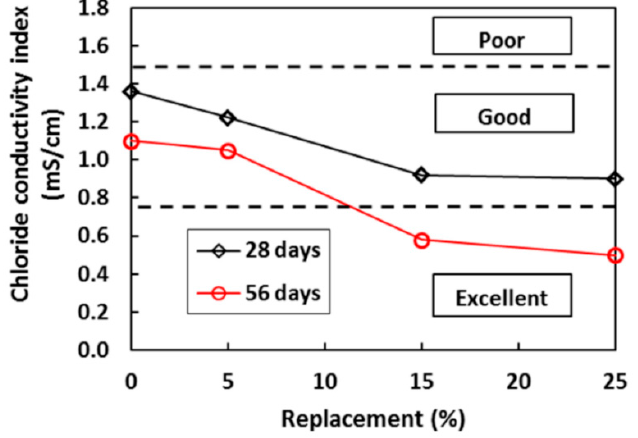
Figure 12. E ff ect of SBA on the chloride conductivity index of concrete Figure 12. Effect of SBA on the chloride conductivity index of concrete [82]. Figure 12. Effect of SBA on the chloride conductivity index of concrete [82].